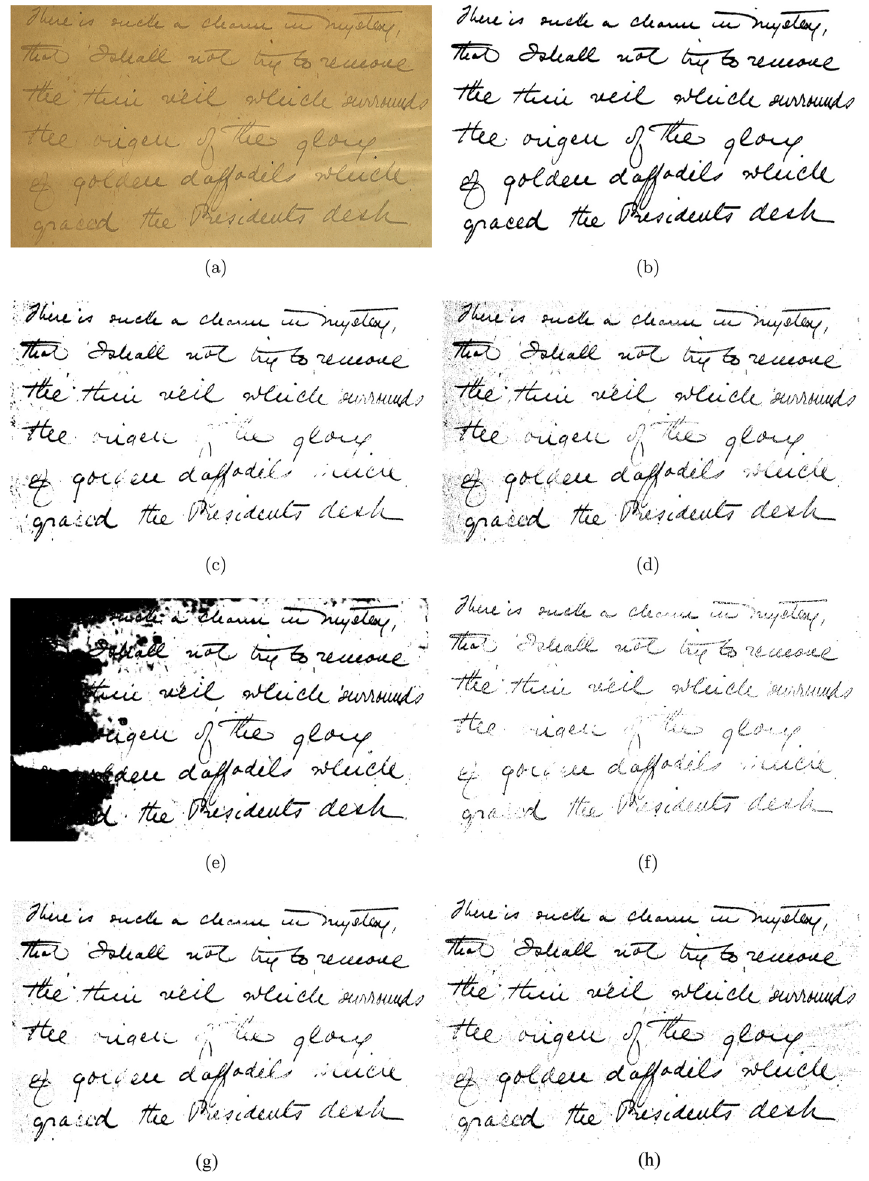
Fig. 12 Binarization results of a sample image by different methods. a Original image , b ground truth , c